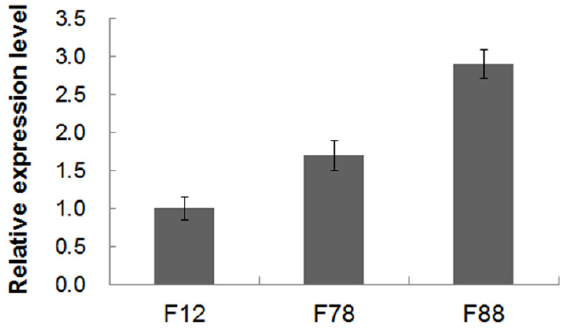
Figure 3. Relative expression levels of GhLRP in T kernels of three transgenic lines. The 3 transcriptional levels of GhLRP in F12, F78 and F88 transgenic lines (20 days after were quantified by real-time PCR. The maize tubulin gene was used as a pollination) in T 3 normalization control.